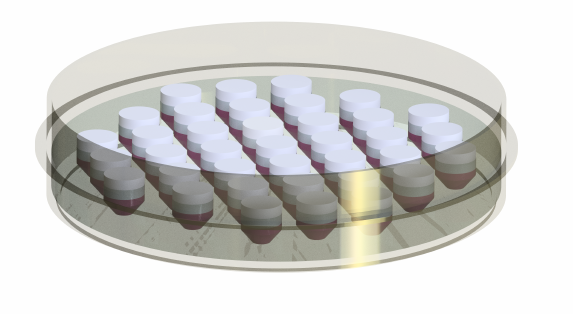
Figure 8. The technical drawing of the highly customizable PDMS mold placed in a petri dish with 37 in vitro 3D